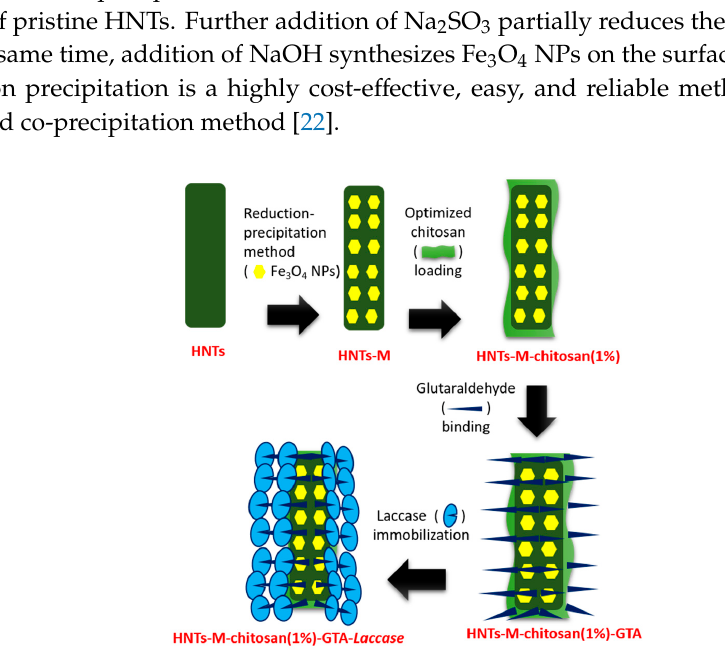
Figure 1. Stepwise synthesis of the halloysite nanotubes (HNTs)-magnetized(M)-chitosan (1%)- glutaraldehyde (GTA)- Laccase.